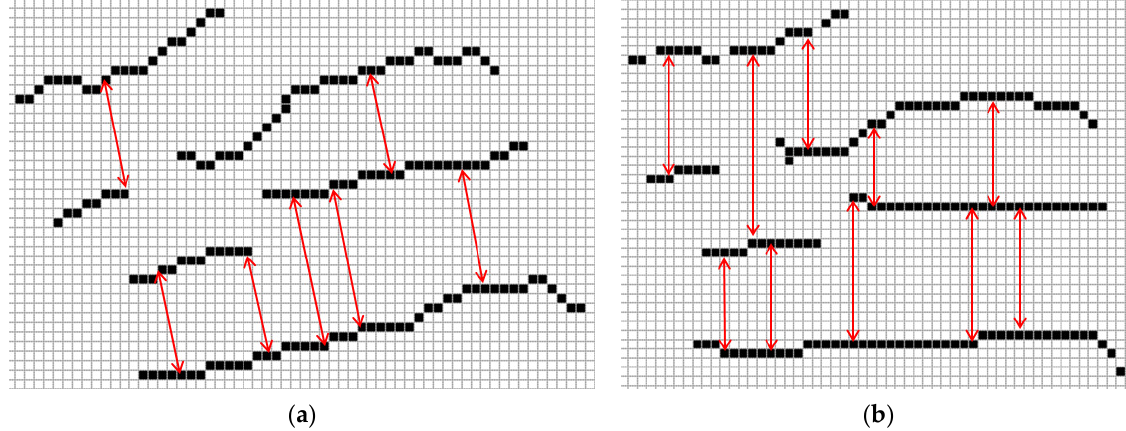
Figure 5. A fragment of a binary image with lines corresponding to the striations ( a ) and the result of their rotation ( b ).